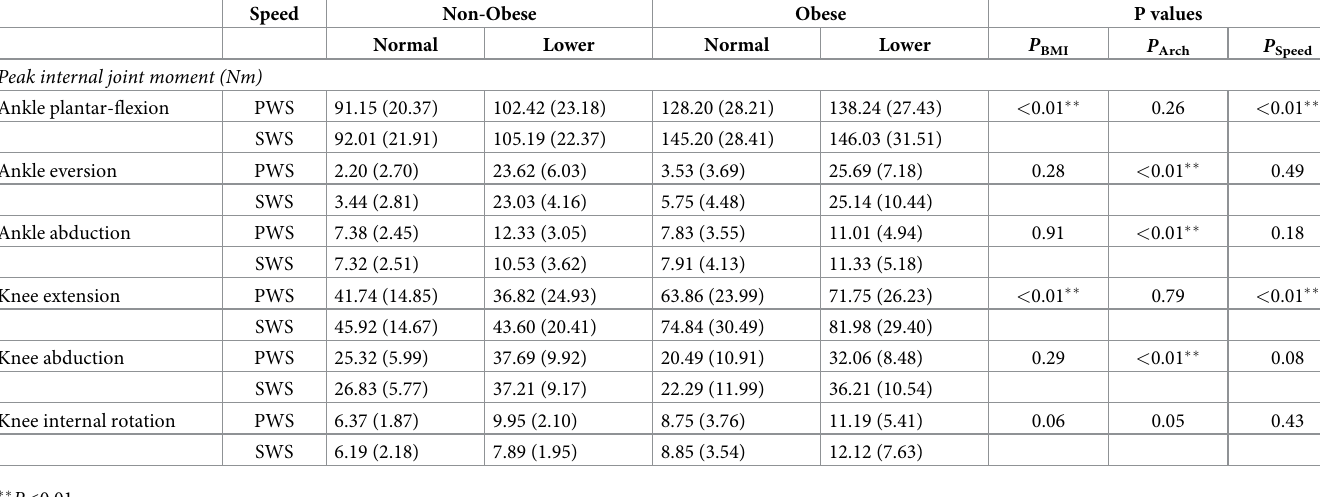
Table 4. Means (standard deviations) for lower-limb joint moments during walking at each participant’s preferred walking speed (PWS) and pedestrian standard walking speed (SWS), 1.25 m/s, across BMI (non-obese and obese) and arch (normal arch and lower arch) groups. Statistical results using three-way mixed ANOVA are also shown ( P BMI : P values of BMI effect; P Arch : P values of arch height effect; P Speed : P values of speed